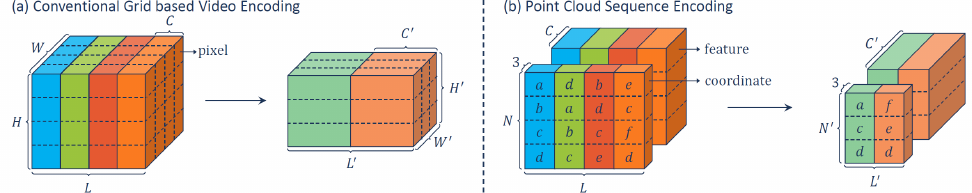
Figure 11. PSTNet [78] sequence